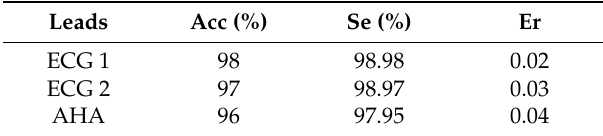
Table 3. Performance Analysis of ESN